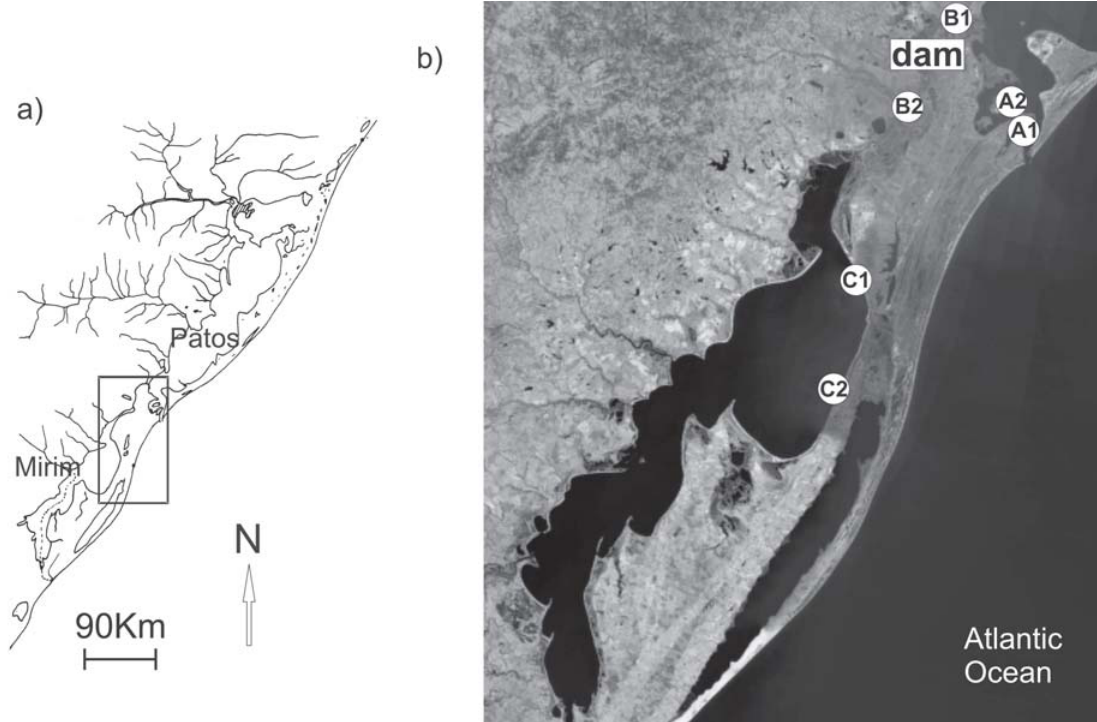
Fig. 1. Patos-Mirim lagoon complex in southern Brazil (a) showing locations of the six beach seine stations (b) at the Patos Lagoon estuary (A1, A2), São Gonçalo Channel (B1, B2) and Mirim Lagoon (C1, C2). A dam is located between stations B1 and